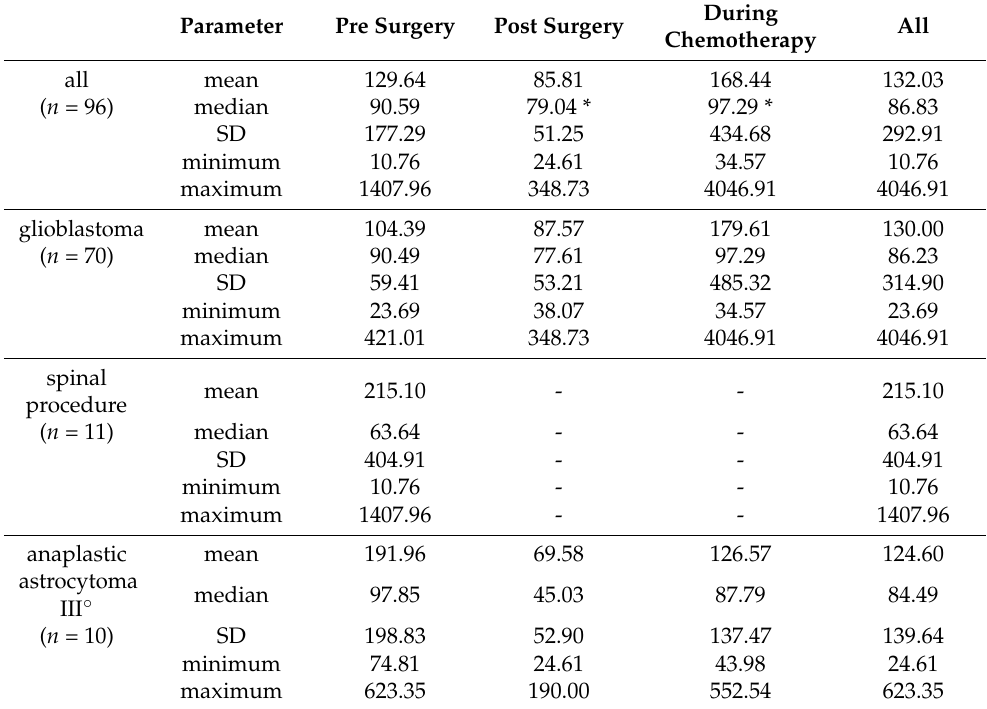
Table 3. Statistical variance of ApoC1 levels ( µ